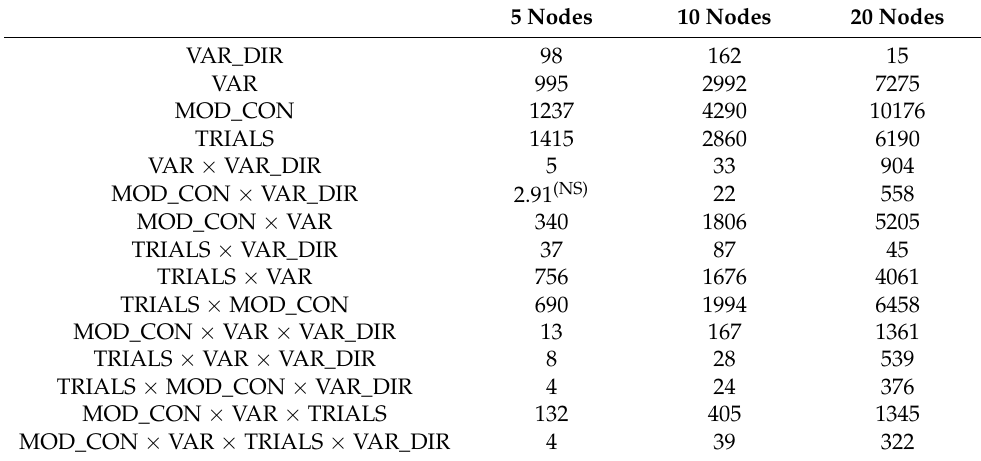
Table 1. Results of the four-way ANOVA (F-value) performed on the Relative Error evaluated after estimating PDC values on 5-, 10- and 20-node models.